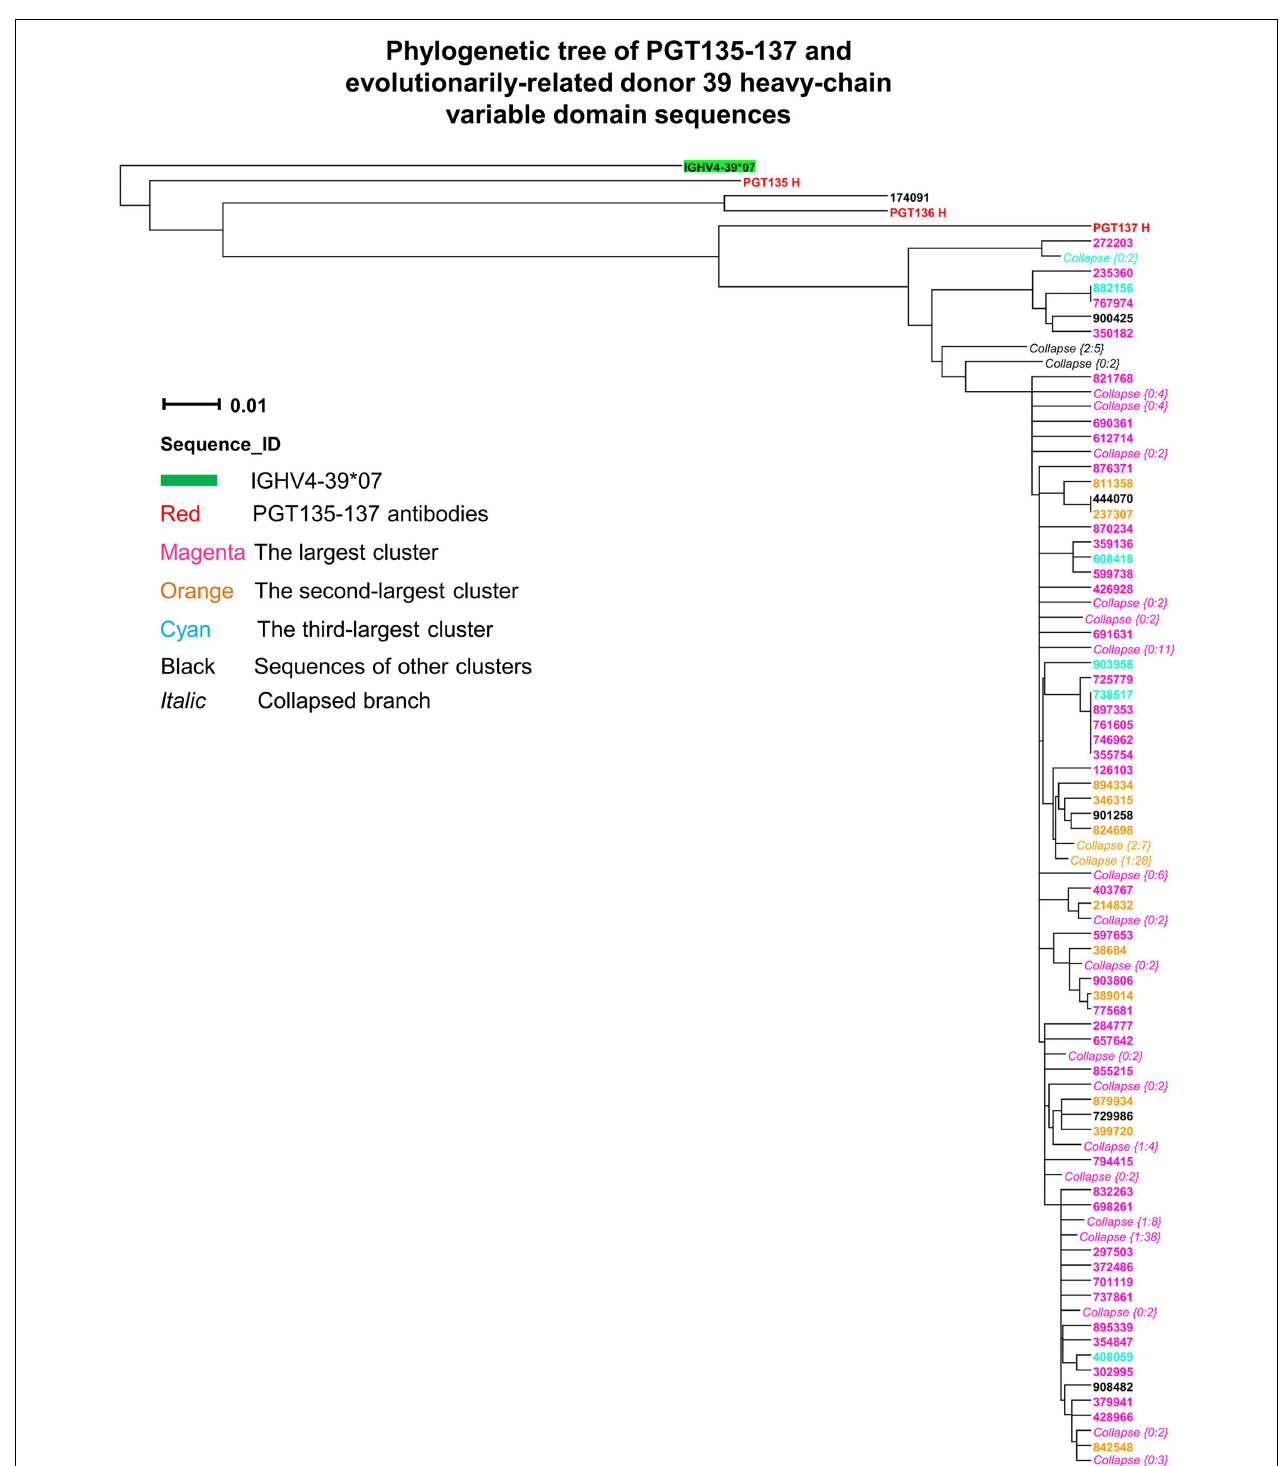
intra-donor phylogenetic analysis was based on an implementation of neighbor-joining (NJ) method. Collapsed branches are indicated by Collapse {N: M} , in which N is the branch depth (number of intermediate nodes) and M is the number of sequences within the branch. All sequences are on the PGT137 branch except for 174091, which is somatically related to